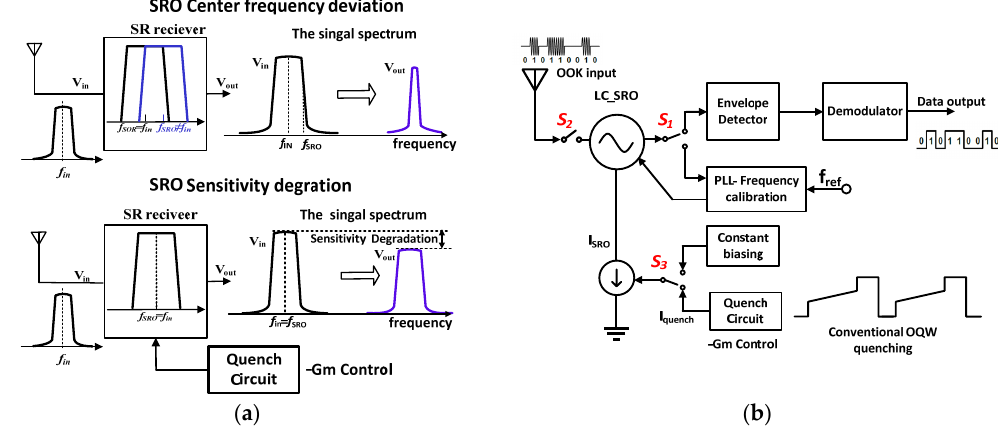
Figure 1. Challenges in the design of SRR: ( a ) SRO’s selectivity and sensitivity under PVT (process ‐ voltage ‐ temperature) variations, and ( b ) the conventional frequency calibration for SR (super ‐ regenerative) receiver with OQW (Concurrent Quenching Waveform).